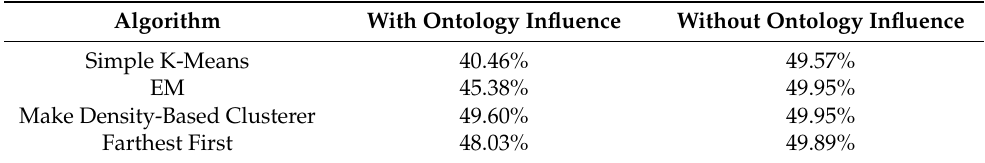
Table 3. Percentage of Incorrect Clustered Instances on Artificial Reviews Dataset.